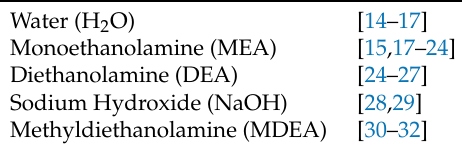
Table 1. Summary of common solvents used in hollow fiber membrane contactors (HFMCs) for CO 2 separation from flue